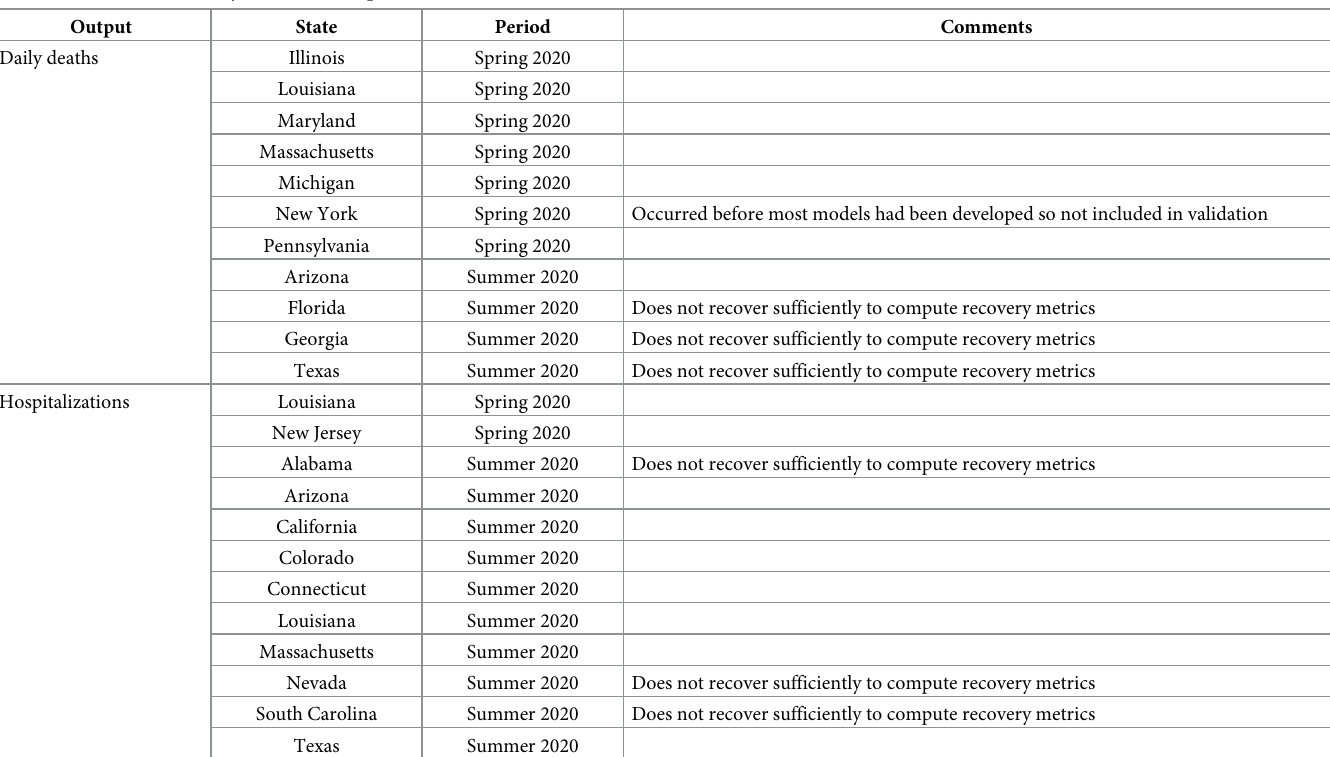
Table 2. Peak events for daily deaths and